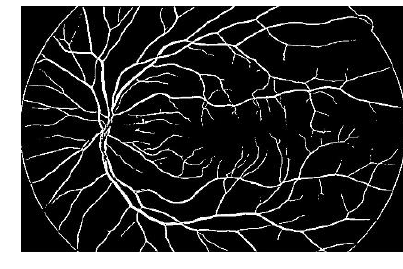
Figure 5.c Output image